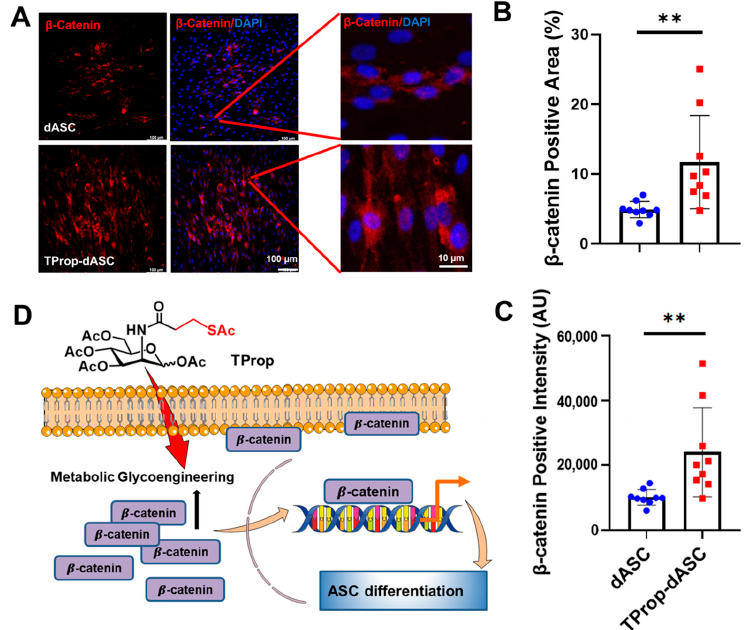
Figure 6. Wnt/ β -catenin signaling activation. ( A ) Immunofluorescence staining of β -catenin (red) in dASCs and TProp-dASCs. Quantification of area fraction ( B ) and intensity of positive β -catenin cells ( C ). β -catenin was more highly expressed in TProp-dASCs compared to dASCs. ** p < 0.01, Student’s t -test. TProp-dASCs experienced significantly increased β -catenin signaling compared to dASCs. ( D ) Schematic representation of how TProp activates cell β -catenin for ASC differentiation. TProp enters ASCs through metabolic glycoengineering. Metabolic-treated dASC (TProp-dASC) caused a nearly twofold expression of β -catenin compared to dASC, which led to more β -catenin translocation to the nucleus. After translocating to the nucleus, β -catenin formed a complex to activate the transcription of downstream genes, thereby promoting the differentiation of ASCs into Schwann-cell-like cells.